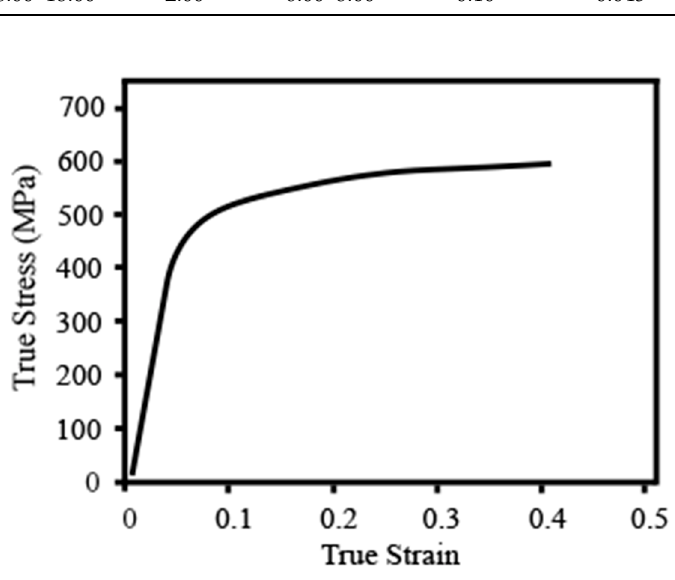
Figure 1. Stress-strain curve of annealed SUS301 foils from micro tensile tests. Table 1. Chemical compositions of SUS301 (wt%).